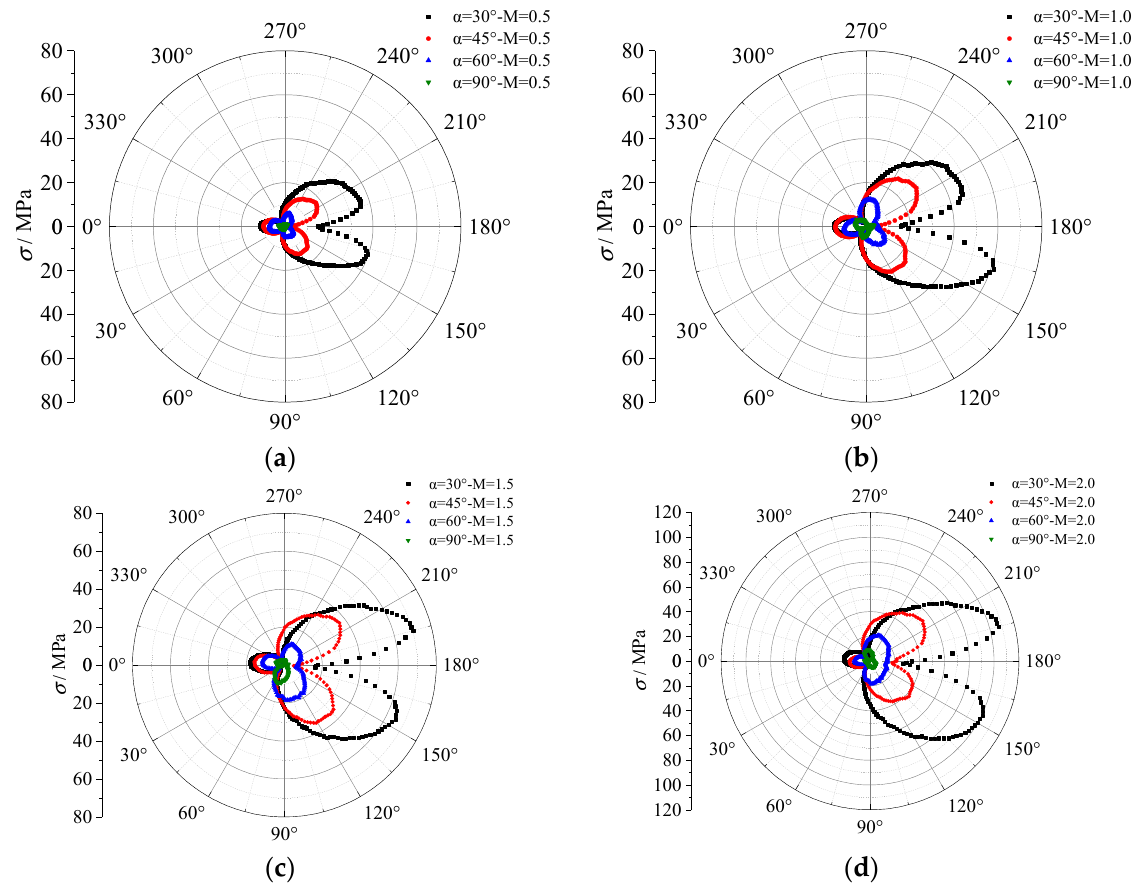
Figure 17. Thermal stress distributions around the research film hole’s inlet. ( a ) M = 0.5. ( b ) M = 1.0.